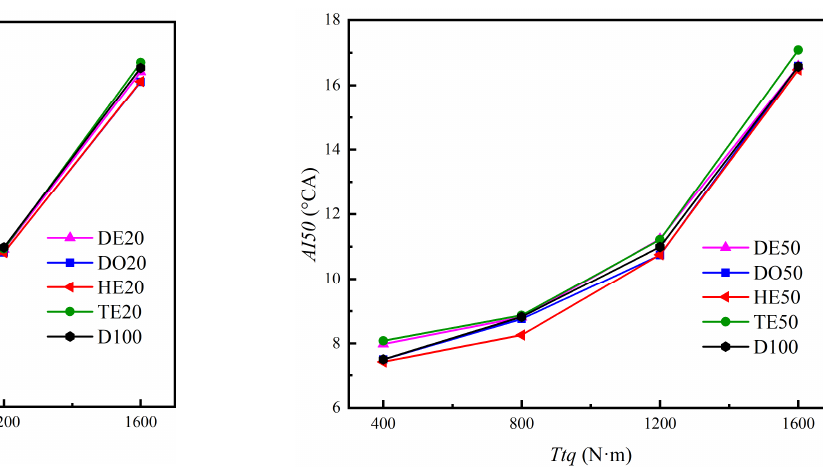
Figure 7. AI50 at 1900 r/min.